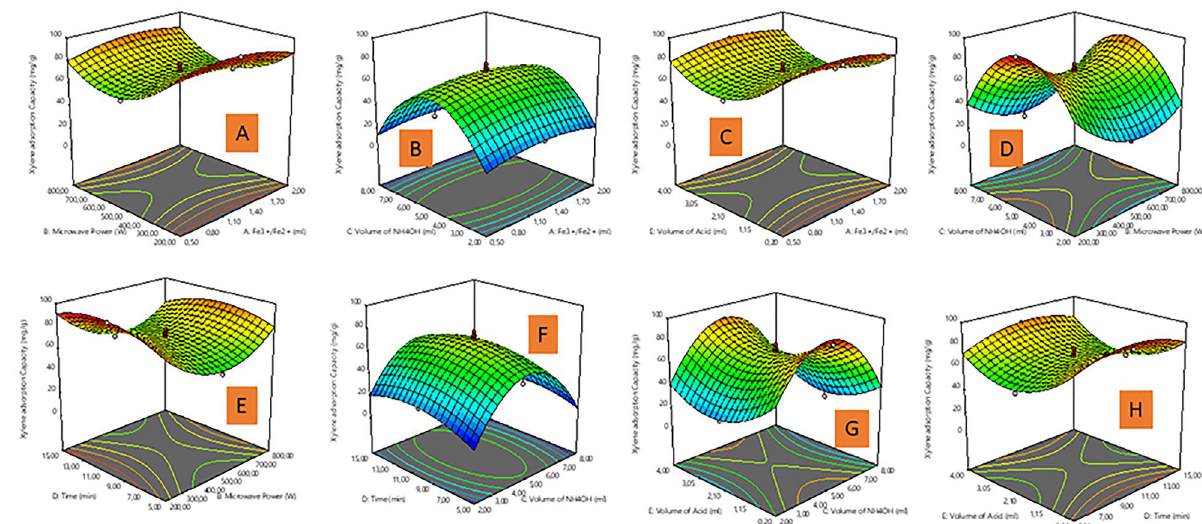
Figure 5. 3D response plots of ( A ) Fe 3+/ Fe 2+ solution and microwave power, ( B ) Fe 3+/ Fe 2+ solution and volume of ammonium hydroxide, ( C ) Fe 3+/ Fe 2+ solution and volume of oleic acid, ( D ) microwave power and volume of ammonium hydroxide, ( E ) microwave power and time, ( E ) volume of ammonium hydroxide and time, ( F ) volume of ammonium hydroxide and time, ( G ) volume of ammonium hydroxide and volume of oleic acid, ( H ) time and volume of oleic acid on xylene adsorption capacity